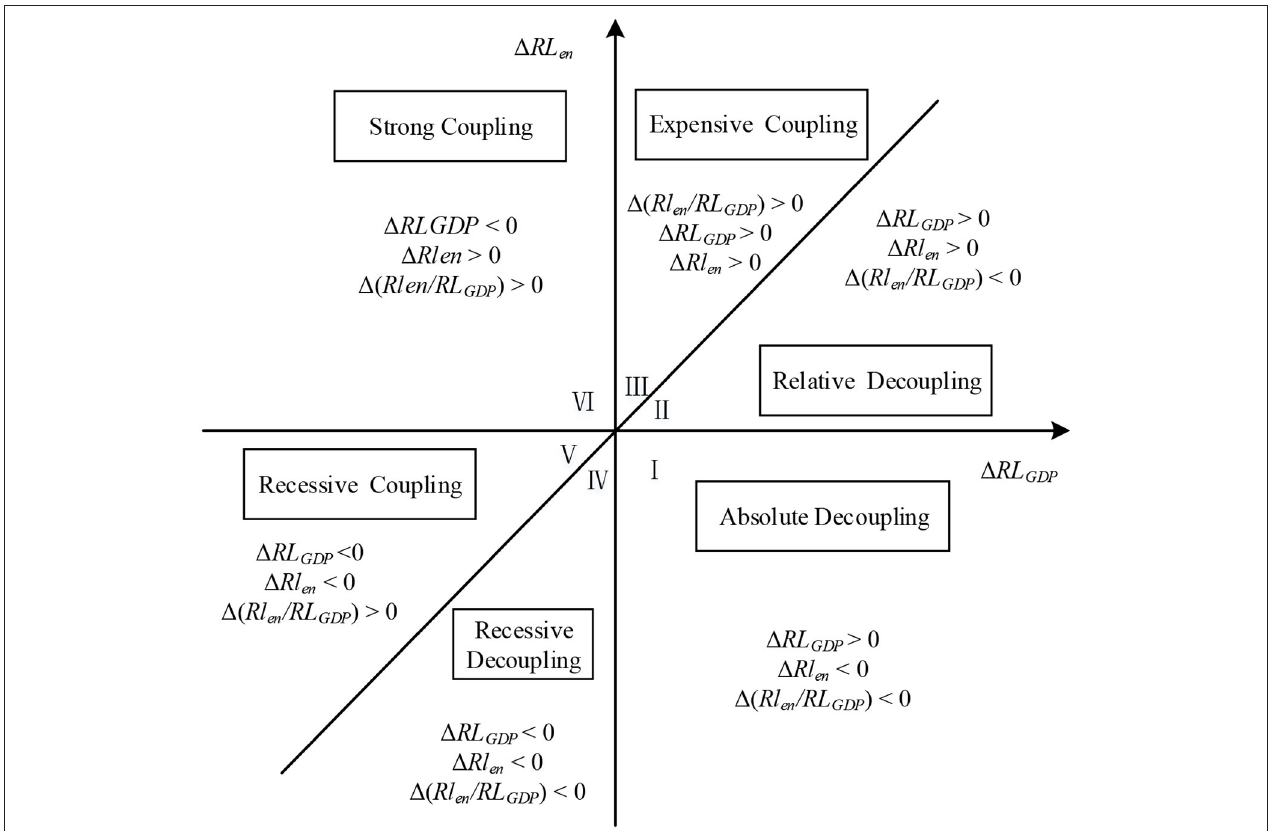
FIGURE 2 | The degrees of coupling and decoupling of energy resilience.